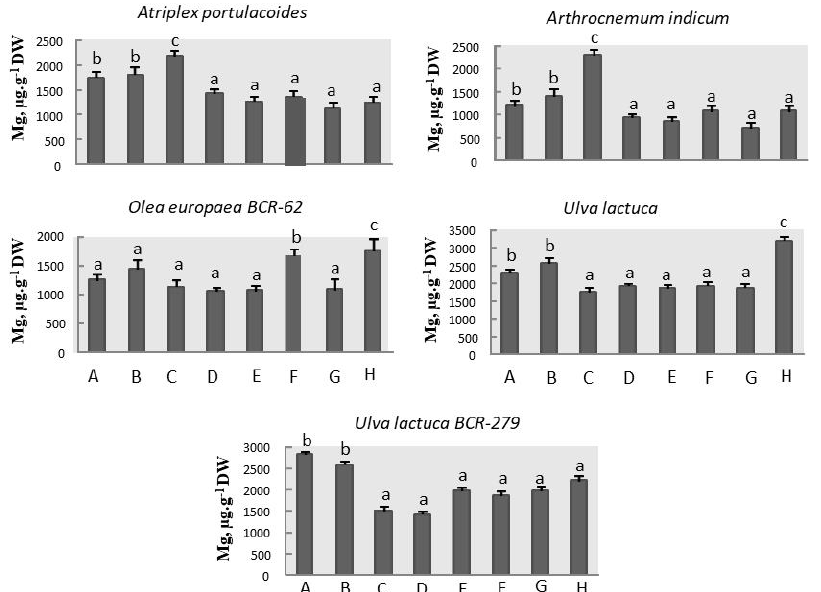
Figure 3. Contents of Mg ( µ g · g − 1 DW) in atriplex portulacoides, arthrocnemum indicum, olea europea BCR-62, ulva lactuca and ulva lactuca BCR-279 using methods A, B, C, D, E, F, G and H. Values were presented as mean ± standard deviation, n = 10. Letters (a, b, c) show a significant difference ( p < 0.05) between the concentrations attained by different extraction procedures.